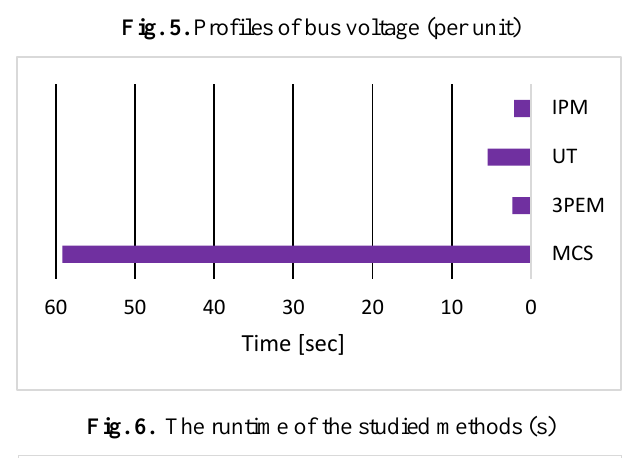
Fig. 6. The runtime of the studied methods (s)